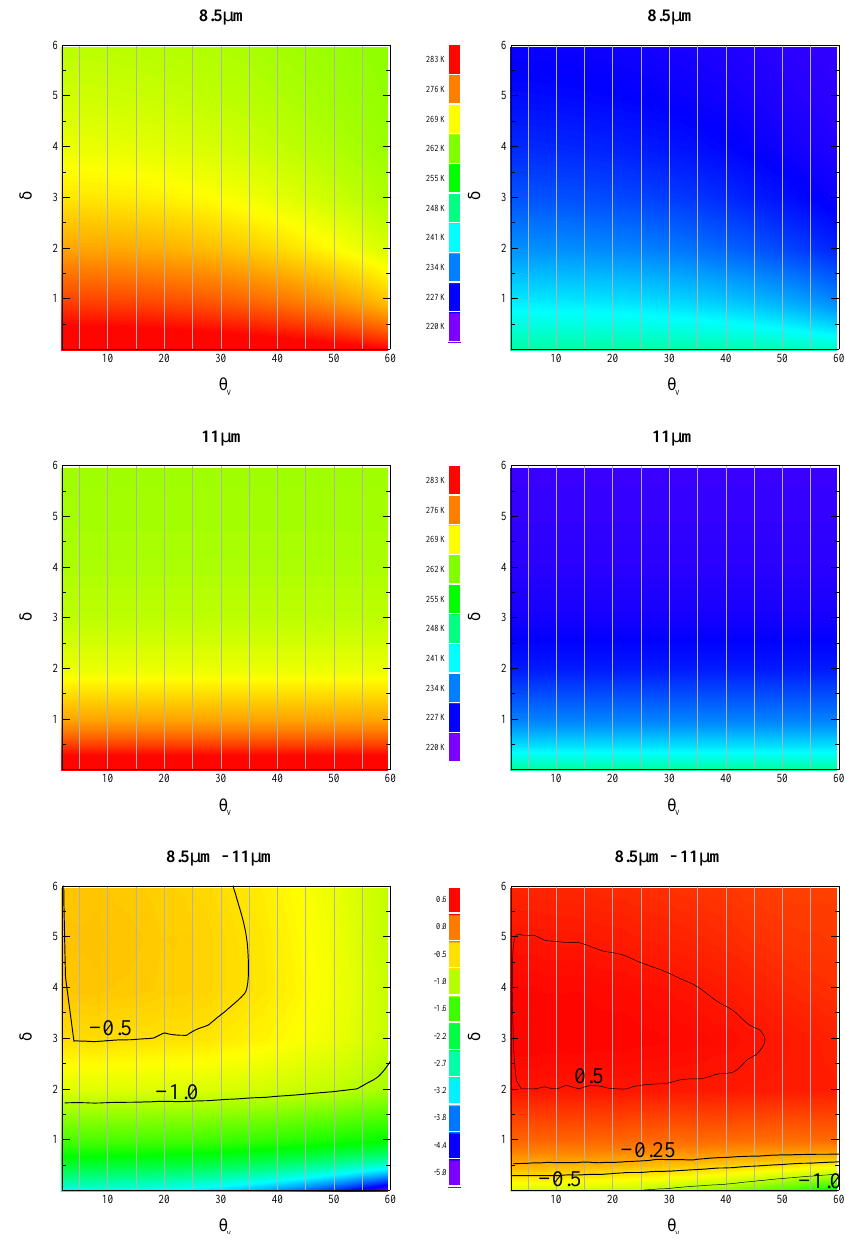
Fig. 8. Simulation for a Mid-Latitude Summer (left) and a Sub-Arctic Winter (right) atmospheric profile of the brightness temperature differences (in Kelvin) between channel at 8.5 and 11µm as a function of view angle for an ice cloud of varying optical thickness at 10km overlaying a lower liquid water cloud of optical thickness 10, located at 5km. Isolines correspond to the thresholds used in the bispectral IR phase